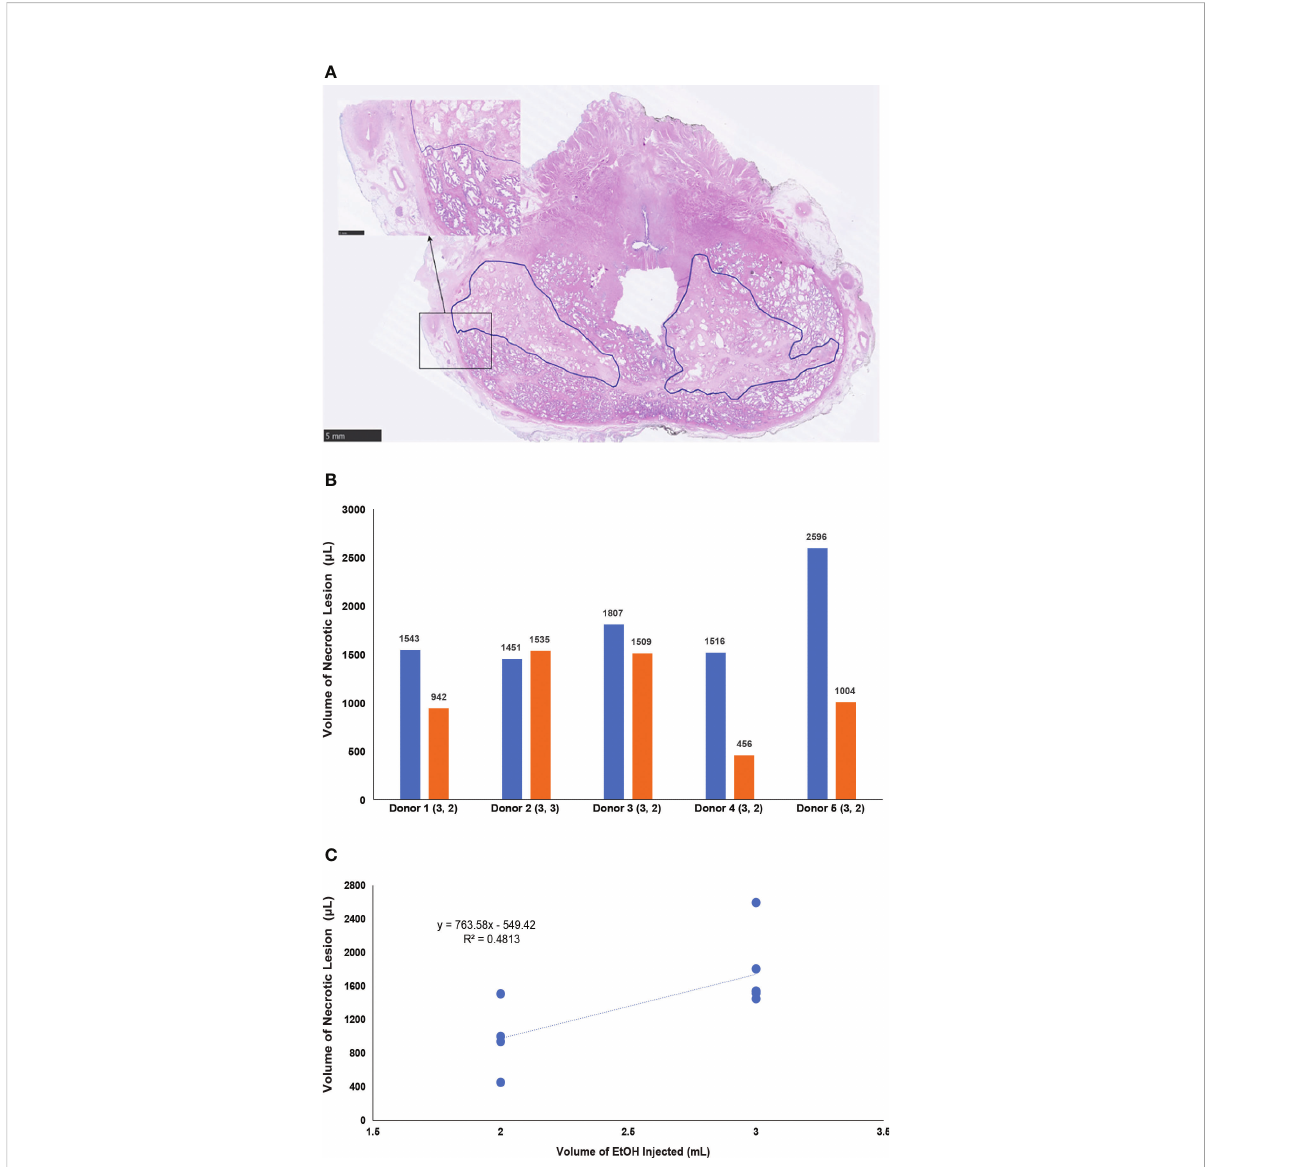
FIGURE 5 (A) Section of the human prostate 8 hours after transperineal intraprostatic ethanol injection. Necrotic areas (traced by blue line) have irregular borders. High power magni fi cation marked by arrow, shows intact prostatic pseudocapsule. (B) Graph summarizing the volume of tissues lesions in 5 human prostates 8 - 16 hours post injection. The volume injected (mL) is listed in brackets under x axis, number above each bar represents the volume of the lesion. (C) Plot demonstrating the correlation of the volume of ethanol and the volume of necrotic